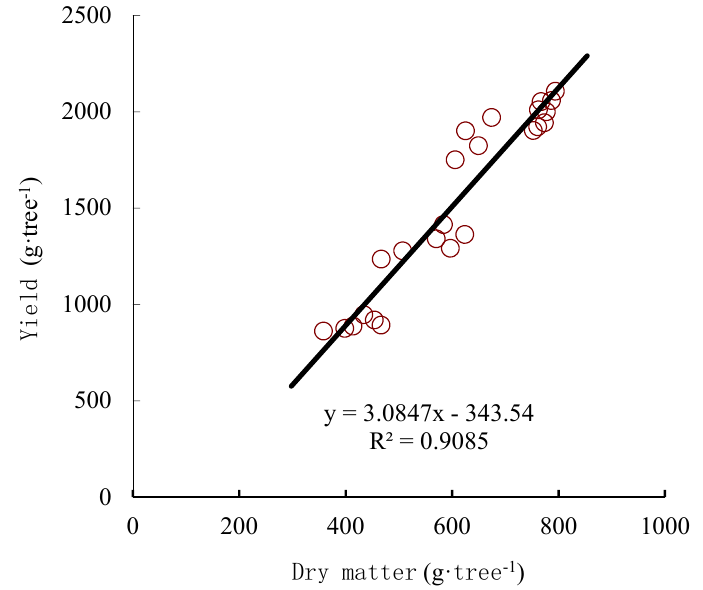
Figure 10. Relationship between yield and dry matterof young apple trees (R 2 = 0.9085, n = 24).